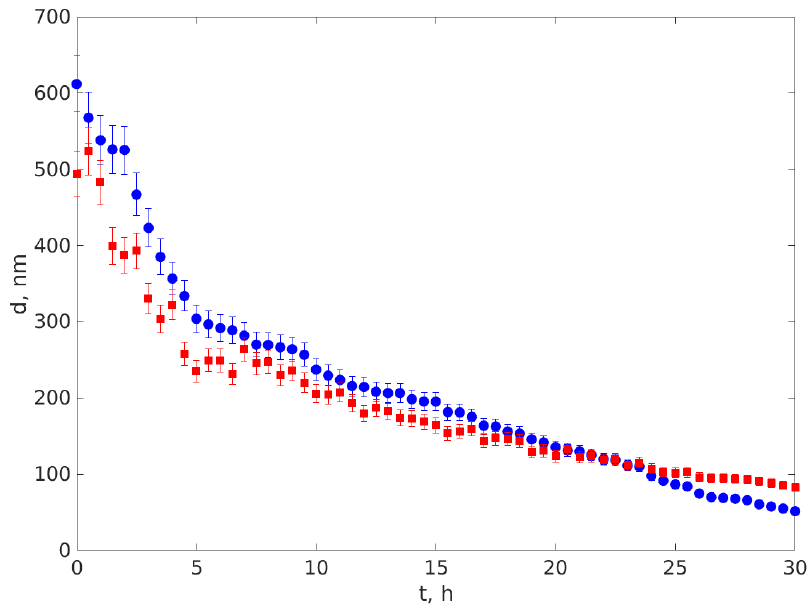
Figure 8. The computed diameters for the sedimentation experiment. The blue dots are the DLS diameters and the red squares are the SEN diameters. diameters and the red squares are the SEN